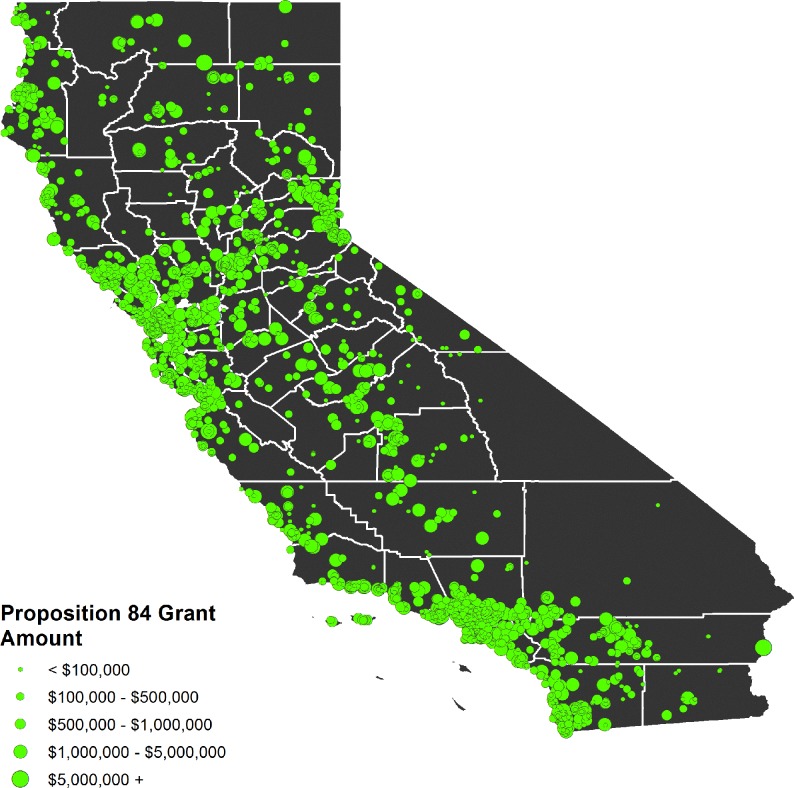
Location of all grants determined to have a local impact.Size corresponds to grant amount. Grants are heavily concentrated in population centers like Los Angeles and the San Francisco Bay Area, but were also disbursed throughout the Central Valley, Sierra Nevada, and along the coast. Geographic data from U.S. Census Bureau [20].